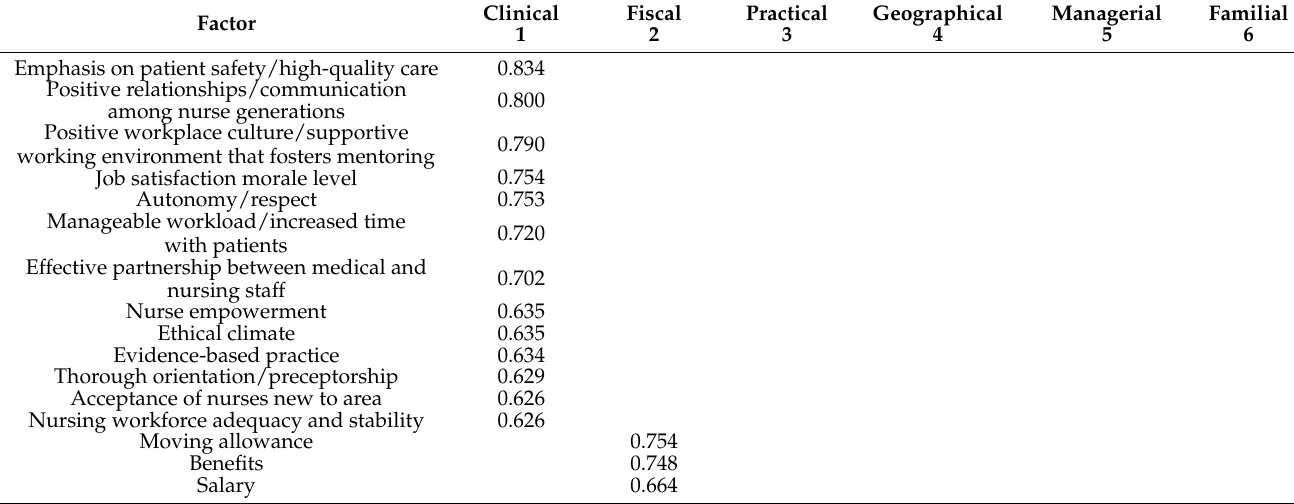
Table 4. Principal component analysis results for NCAQ.